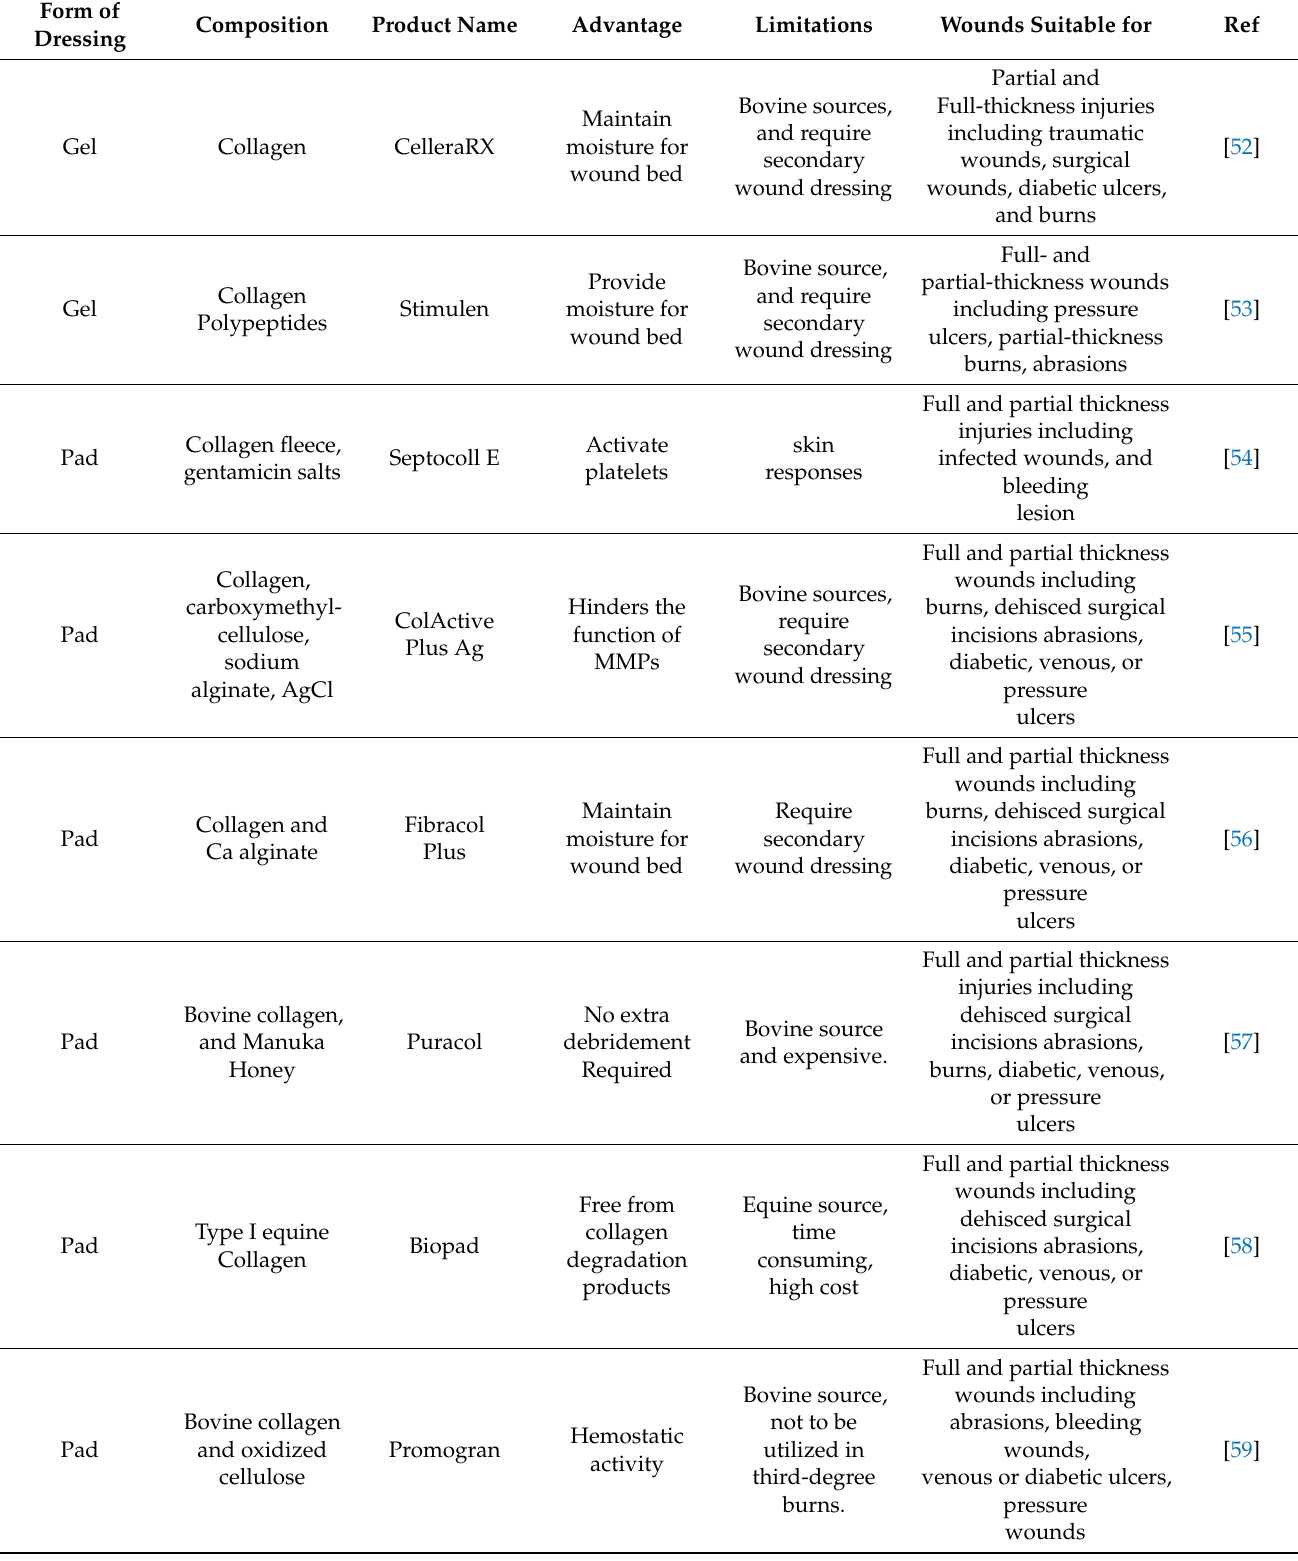
Table 1. Summary of commercially available collagen-based wound